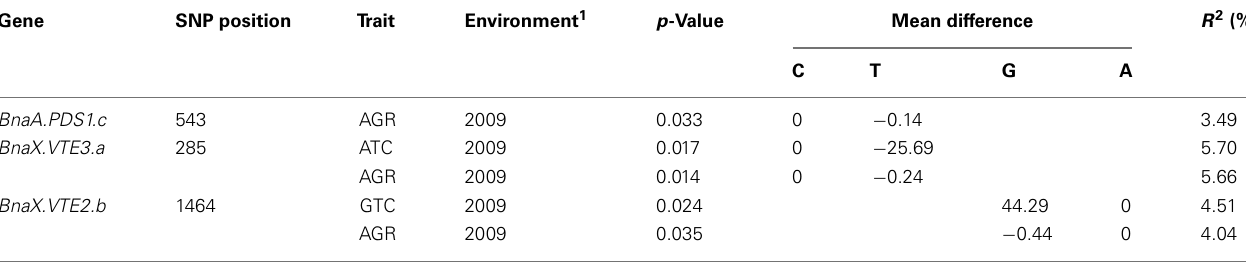
Table 9 |Association between SNPs and tocopherol traits and allele mean differences of panel 2 accessions.